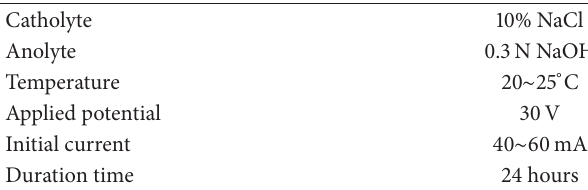
Table 4: Conditions for chloride diffusion test (NT BUILD